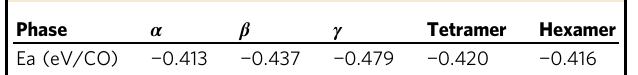
Table 1 Averaged adsorption energy of single CO molecule in various